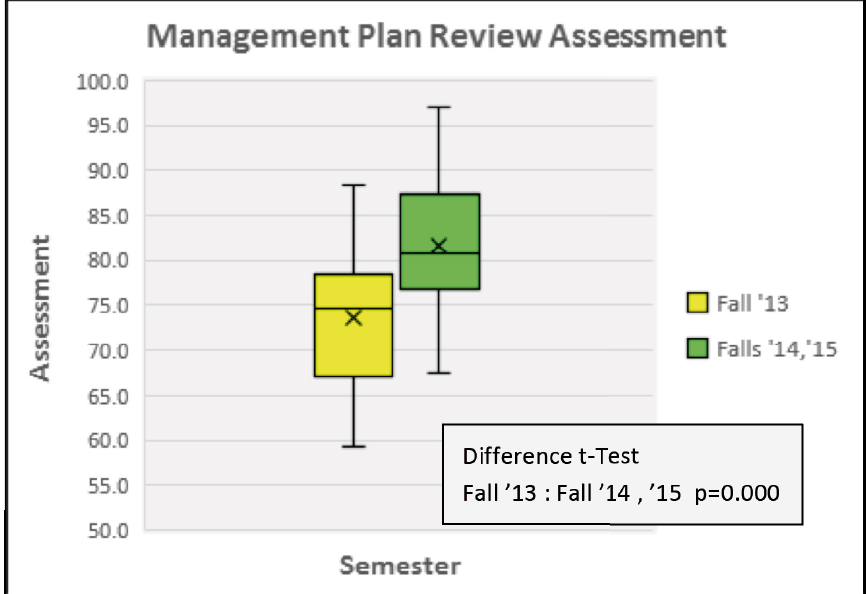
Fig. 5. Comparison of Management Plan Scores Before and After the Addition of an Earlier Feasibility